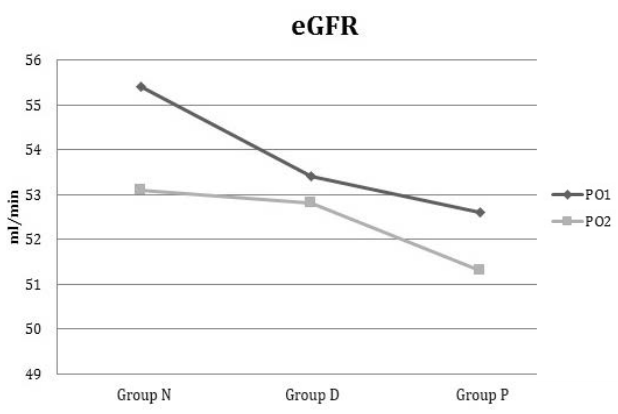
Fig. 1 - Evolution of eGFR from first postoperative day to second postoperative day in NAC, Dopamine and Placebo